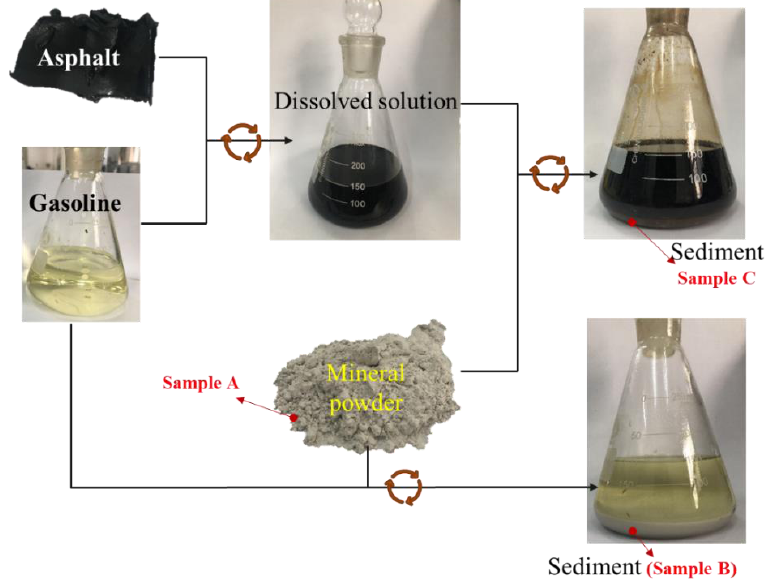
Figure 1. Schematic diagram of sample preparation.